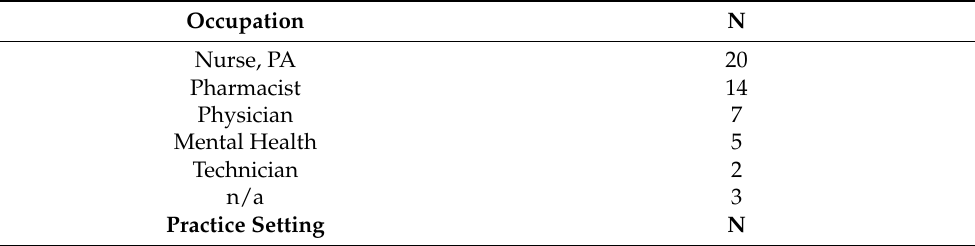
Table 1. Participant characteristics—healthcare